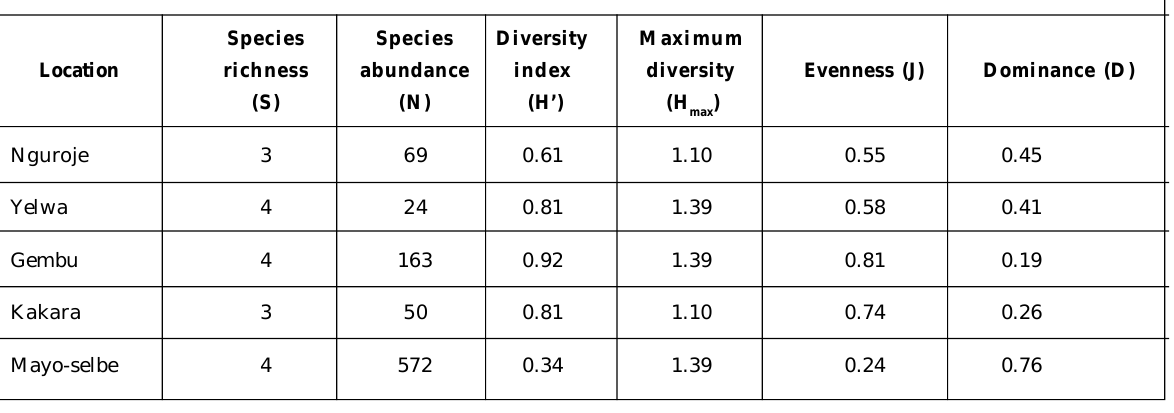
Table 4: Species abundance and diversity of anopheline vectors of malaria across the altitudinal locations